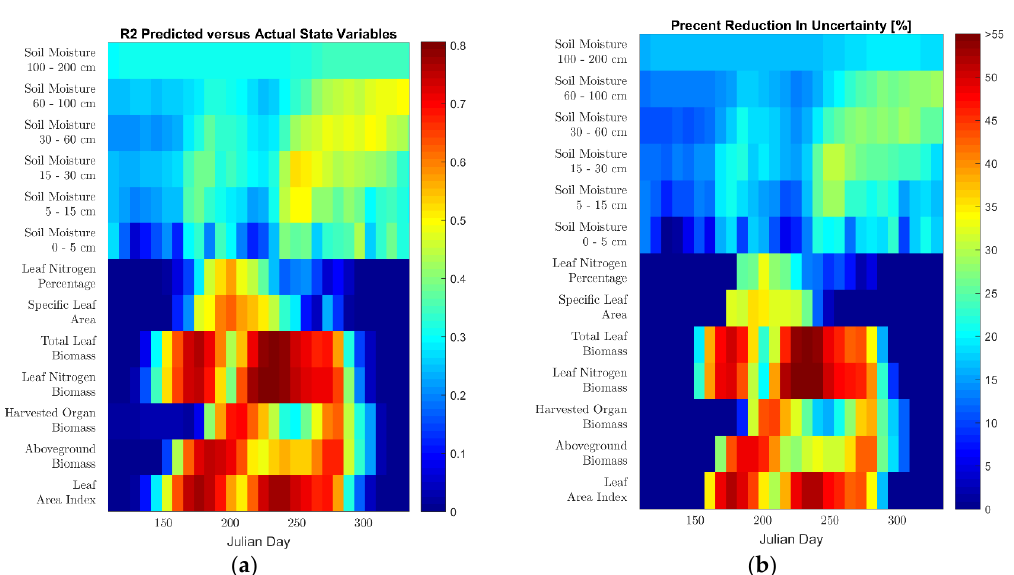
Figure 9. ( a ) CV R 2 and ( b ) CV PRU physical state variable prediction results for clusterless calibration over entire US Corn Belt.